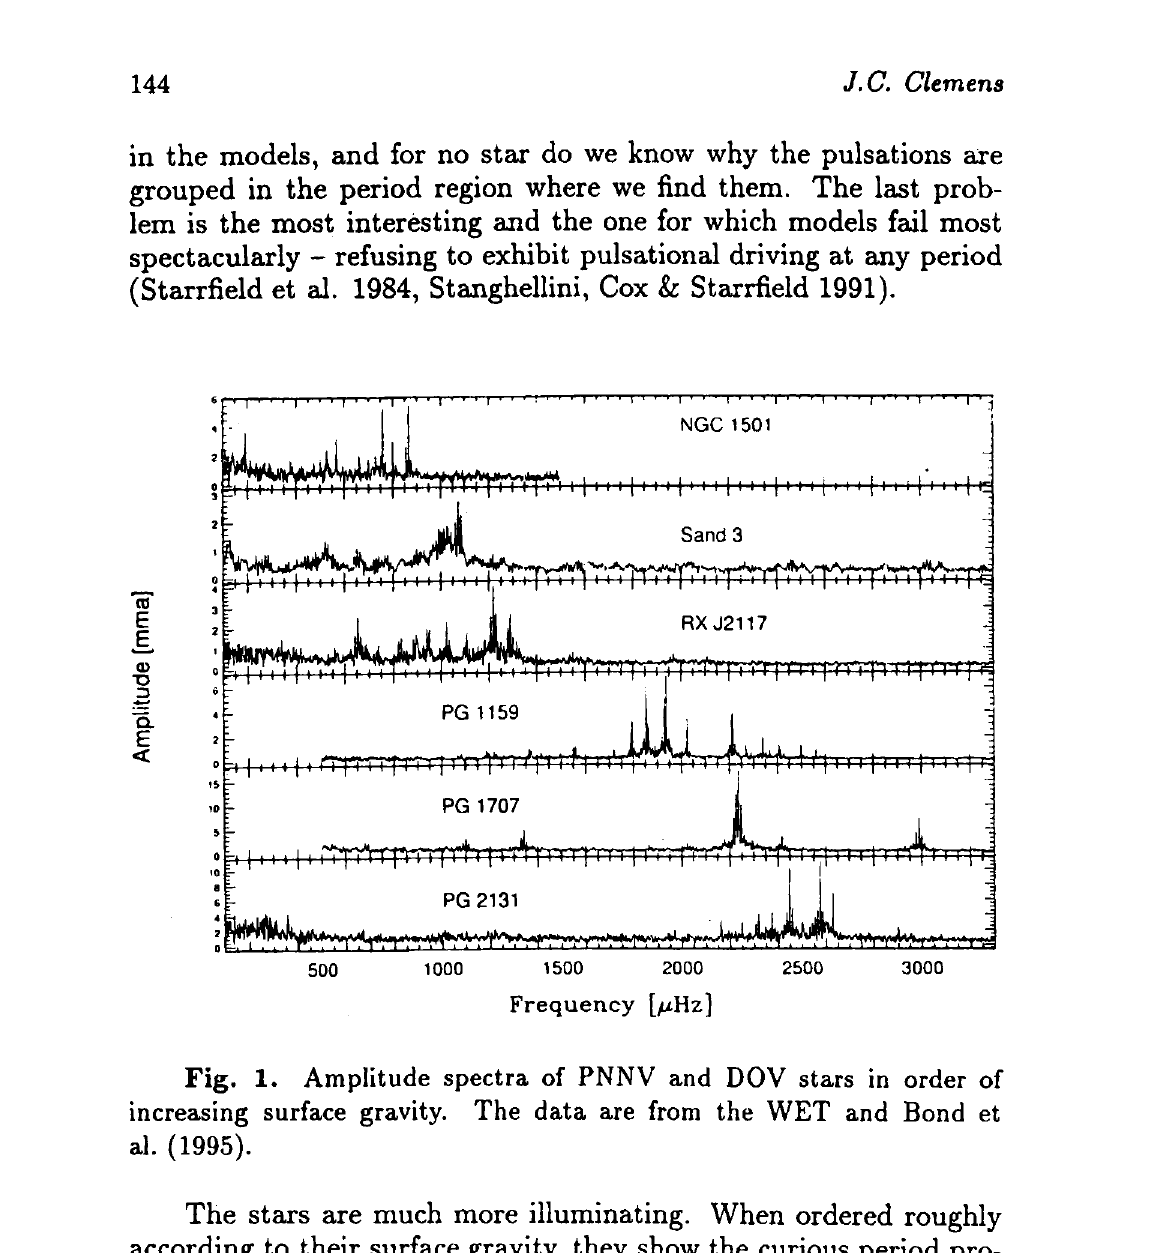
Fig. 1. Amplitude spectra of P N NV and D OV stars in order of increasing surface